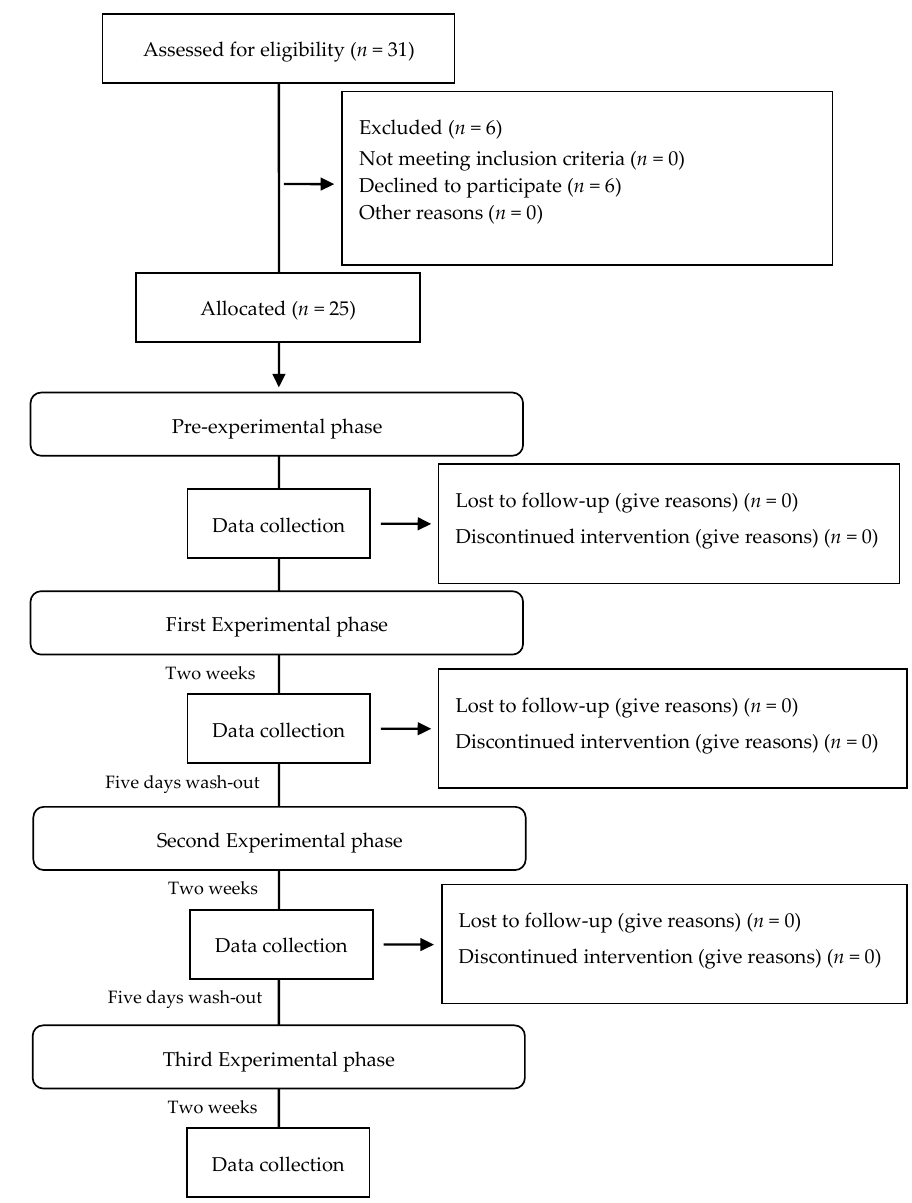
Figure 1. Flow diagram for patient enrollment and study design.